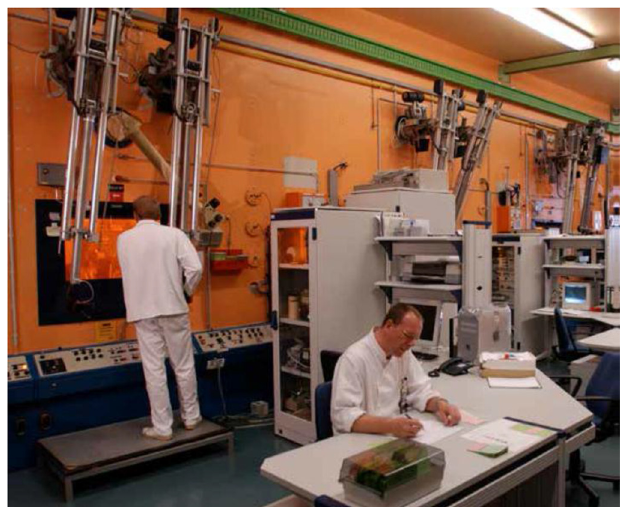
Fig. 5. JRC hot-cells.